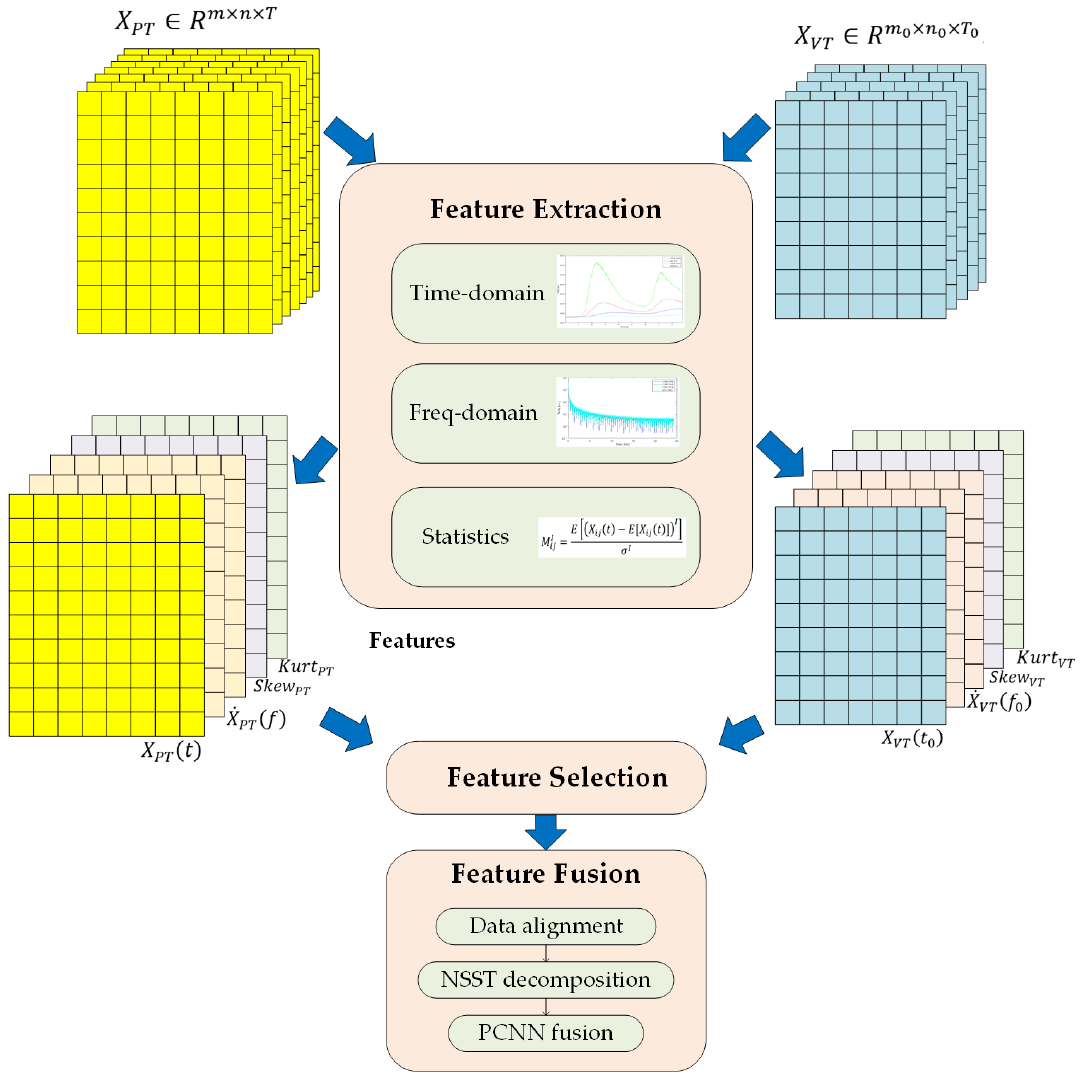
Figure 5. The schematic diagram of the proposed FE ‐ S ‐ F framework for multi ‐ excitation infrared fusion.